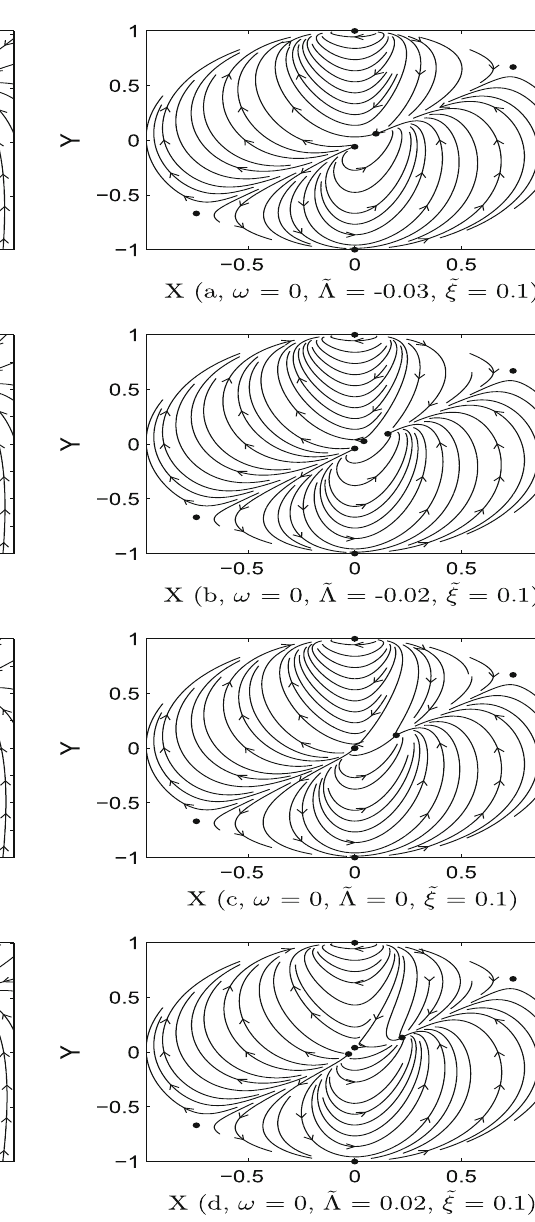
and x 2 respectively denote the dimensionless ˜ H and ˜ ρ as defined in Eq. (7). X and Y are the coordinates on the Poincaré sphere as defined in Eq. (47). The dotted circles represent fixed